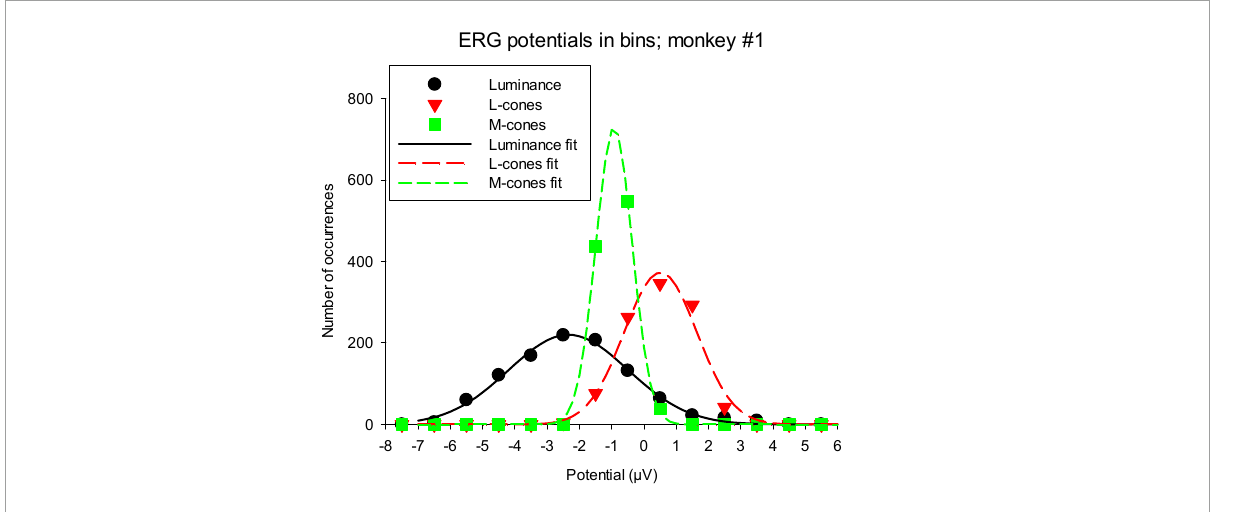
FIGURE7 Distribution of wnERG potentials in monkey #1: the recordings were divided in bins of 1 µ V width and the number of occurrences of wnERGs potentials within each bin is plotted as a function of the bin midpoint. The curves are fits of Gaussians to the data. The values of σ of the Gaussians are 1.84, 1.13, and 0.57 for luminance, L-cone driven and M-cone driven responses,